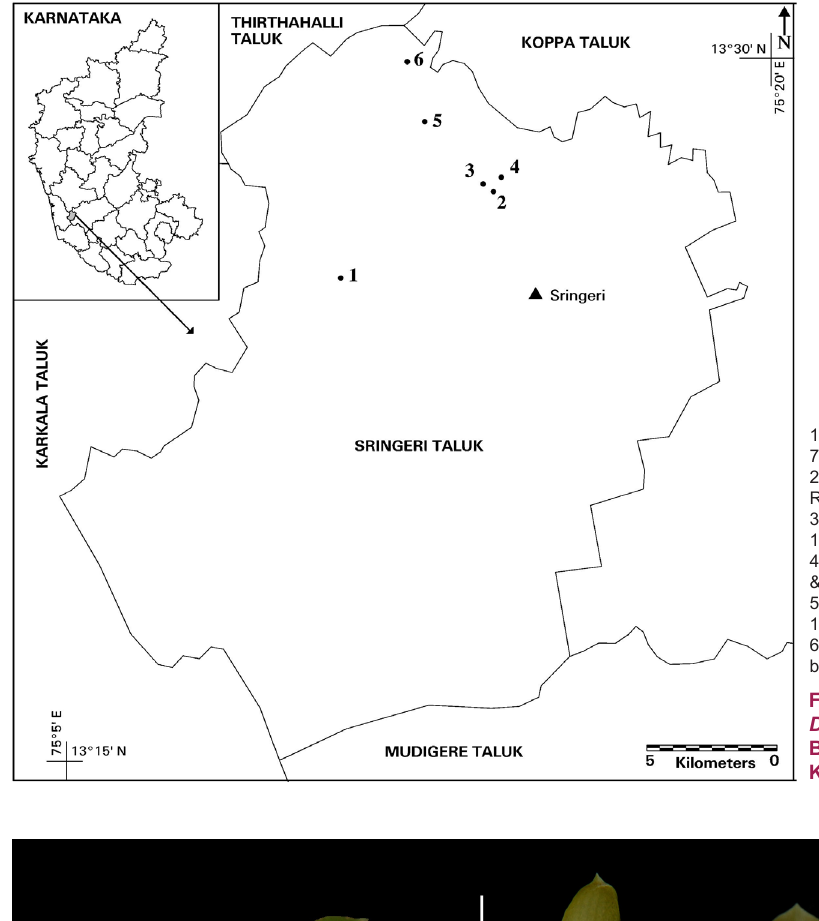
Collection localities• 1 - Kigga (10km from Sringeri - 13 0 25’20.76”N & 75 0